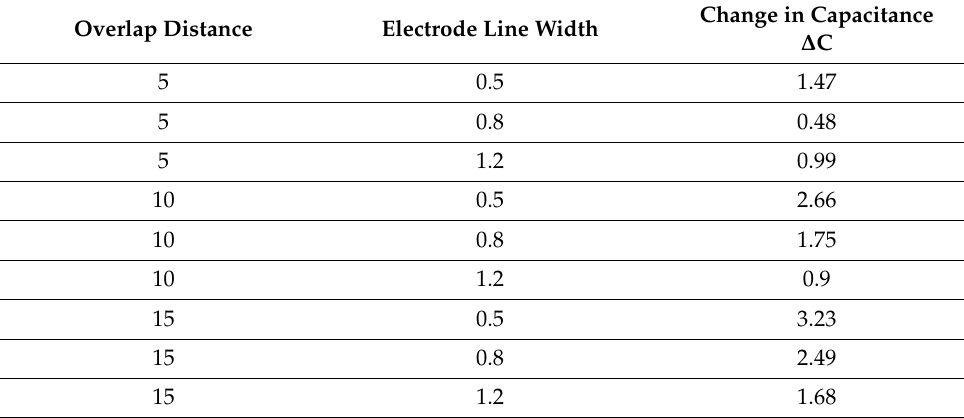
Table 1. Computation of Sensor performance measures.